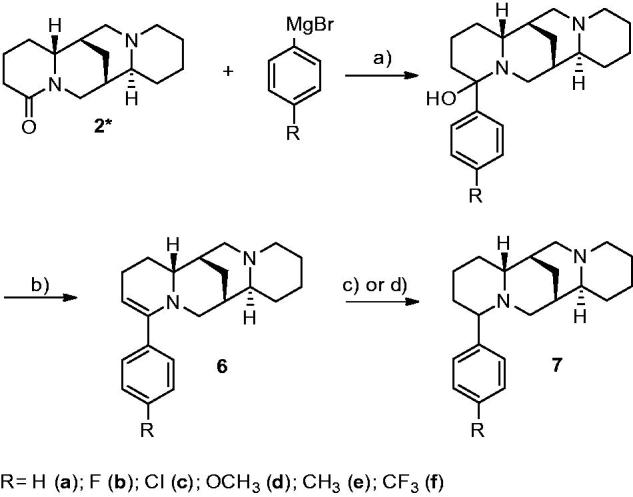
Reagents and conditions: (a) dry Et2O; reflux, 2 h; (b) dil. HCl; (c) H2/Pd-C, EtOH, r.t.; (d) NaBH4, EtOH; reflux, 4 h. *(±)-lupanine, for the sake of simplicity, only one enantiomer is shown.